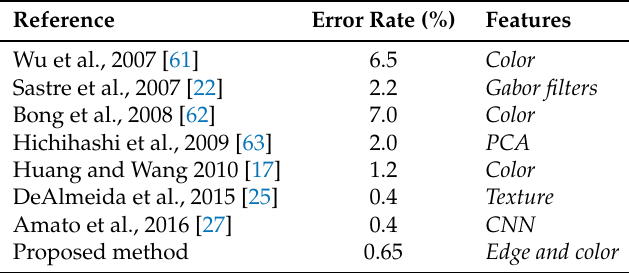
Table 2. Comparison of related